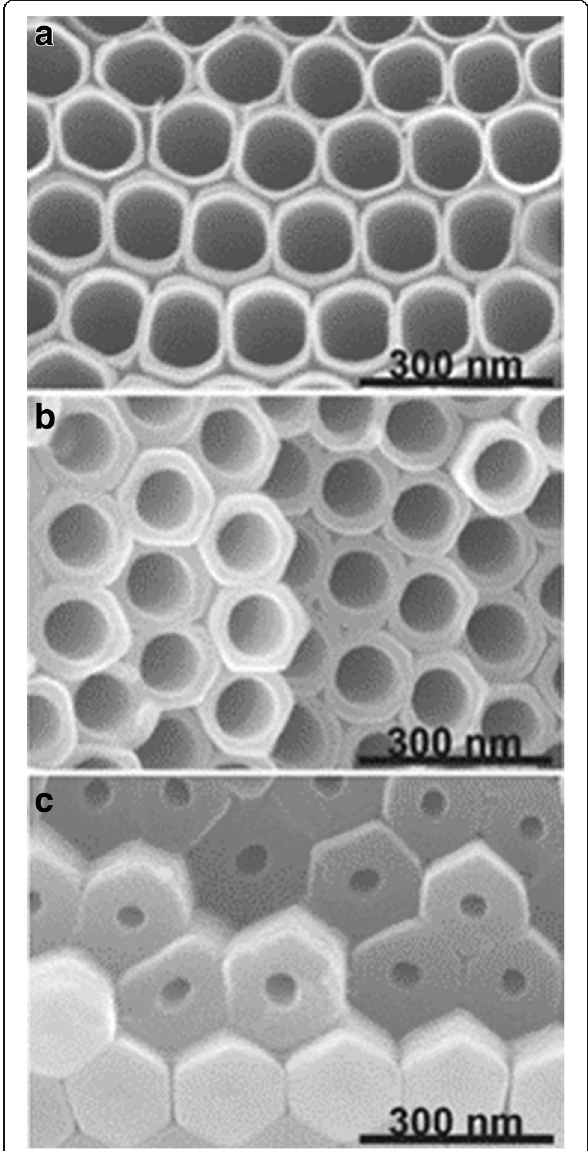
Fig. 5 SEM images of TiO 2 nanotubes. The nanotubes are formed in ethylene glycol electrolytes containing 0.27 M NH 4 F by repeated anodization of Ti. The cross sections are taken at the top of the layer, in the middle, and at the bottom of the layer. Reproduced from ref. [43]